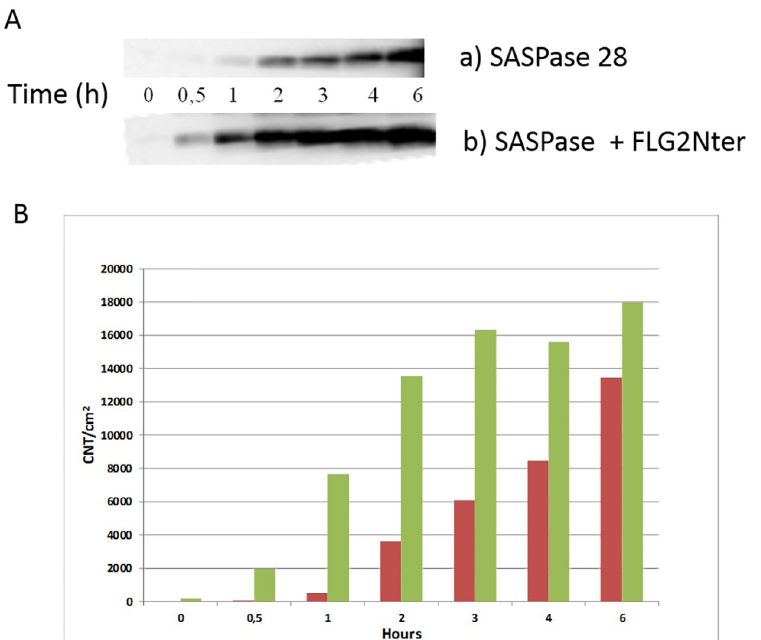
Fig 6. The N-terminal domain of Filaggrin 2 enhances the auto-activation of 28 kDa SASPase to its active 14 kDa form. Recombinant SASPase 28 was incubated from 0 to 6 hours in the presence of equimolar amounts of recombinant protein FLG2Nter (aa 2–213). The auto-processing of 28 kDa SASPase into its catalytic 14 kDa form was analyzed by Western blot analysis using a monoclonal antibody that detects SASPase. A cropped image from S5 Fig shows the 14 kDa catalytic of SASPase. (B) semi quantitative analysis of the SASPase 14 band in the presence of FLG2Nter (green bars) as compared to SASPase 28 alone (red bars).